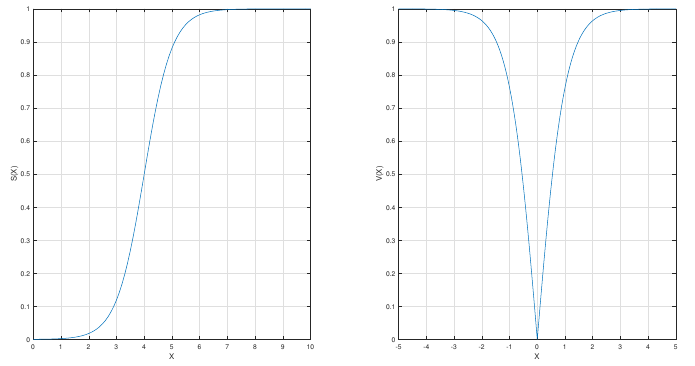
Figure 2. S-shaped and V-shaped transfer